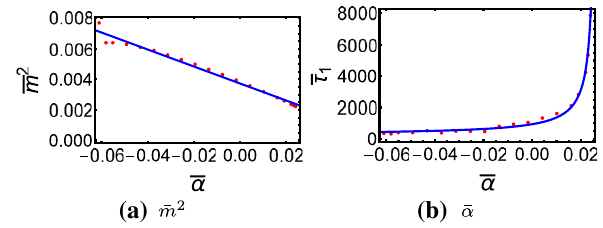
Fig. 18 The effects of ¯ α to the scaled mass ¯ m 2 and the scaled lifetime ¯ τ 1 of the first KK resonance for case 2. Red dots are numerical results and solid blue lines are fit functions. In the left panel the fit function is ¯ m 2 = 0 . 00373 − 0 . 0557 ¯ α , in the right panel the fit function is ¯ τ 1 = + 0 . 1 14 . 3 − 540 ¯ α